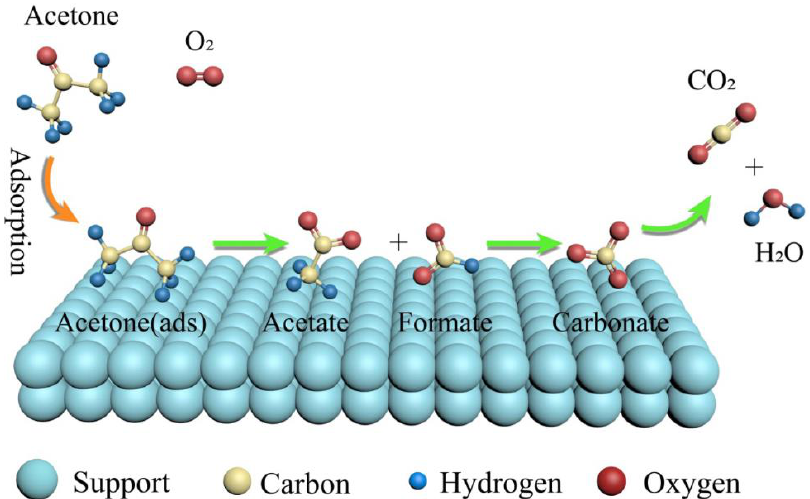
Figure 14. Eley–Rideal mechanism illustrated. Reprinted with permission from Mu et al., 2021, [31] Figure 14. Eley – Rideal mechanism illustrated. Reprinted with permission from Mu et al., 2021,[31] Elsevier Elsevier Ltd.